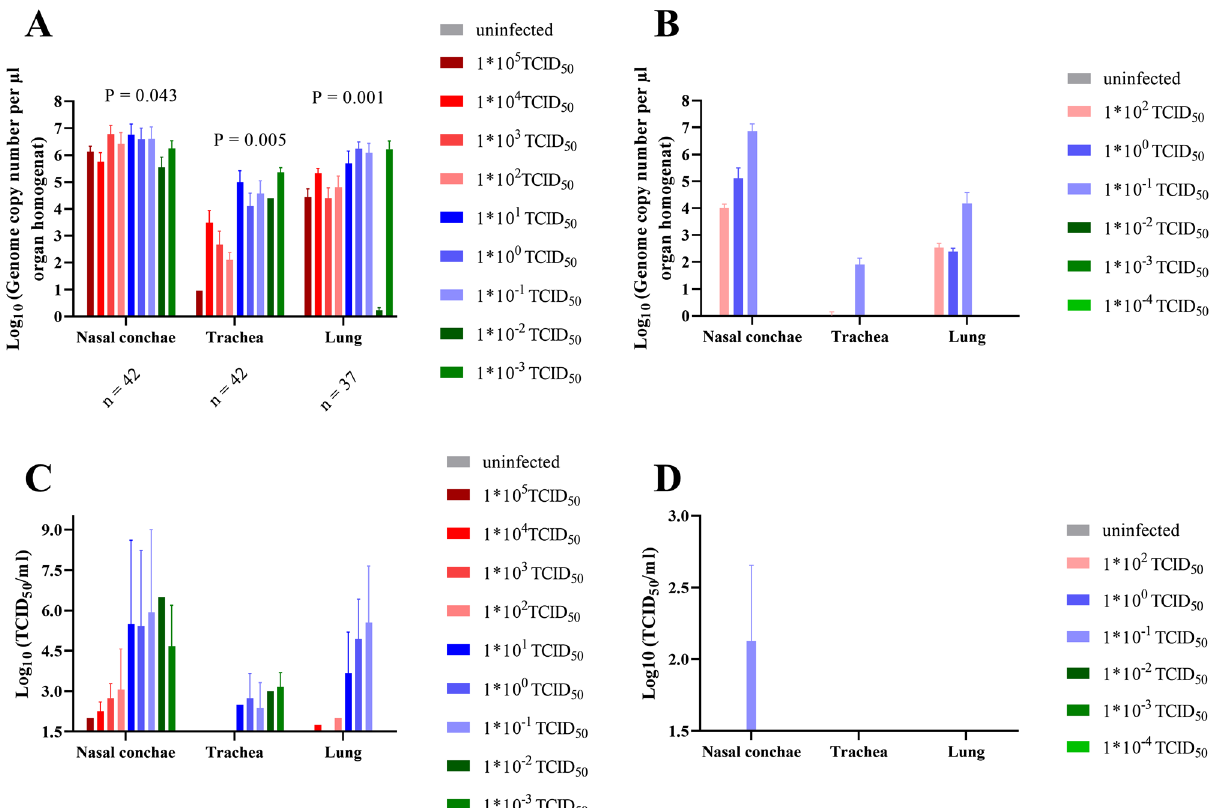
Figure 8. Genome copy number (Log 10 ) of SARS-CoV-2 RNA and replication competent virus (Log 10 TCID 50 / ml) detected in the respiratory tract. ( A ) Genome copy number (Log 10 ) of viral RNA and ( C ) replication competent virus (Log 10 TCID 50 /ml) detected in the respiratory tract samples at 7 dpi. ( B ) Genome copy number (Log 10 ) of viral RNA and ( D ) replication competent virus (Log 10 TCID 50 /ml) detected in the respiratory tract samples at 10 dpi. Statistically significant differences in RNA levels were determined at 7 dpi. Further details on statistical analysis are shown in Table S1. Colors match and represent results from the same hamsters as shown